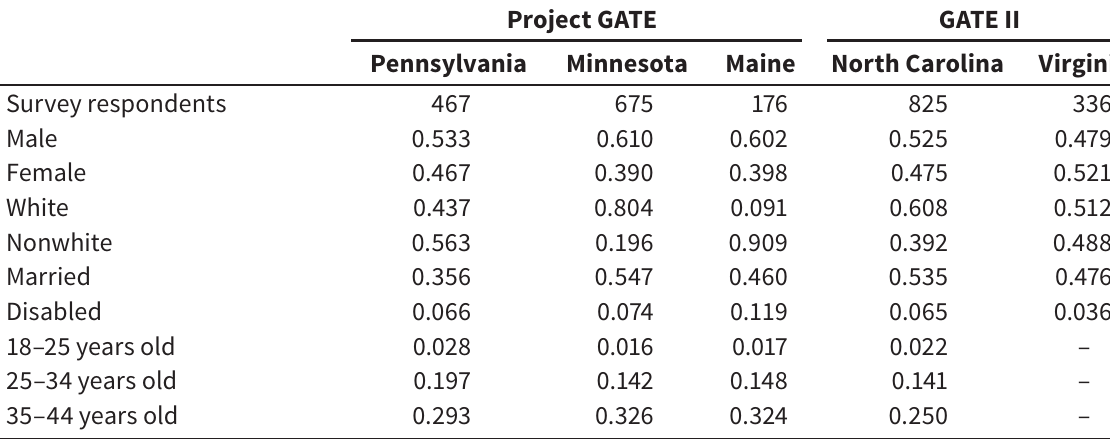
Characteristics of survey